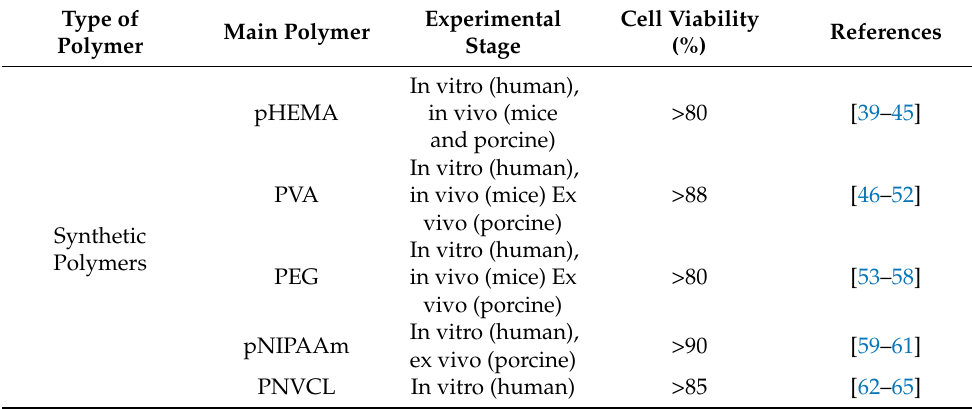
Table 1. Summary of studies carried out with different synthetic and natural